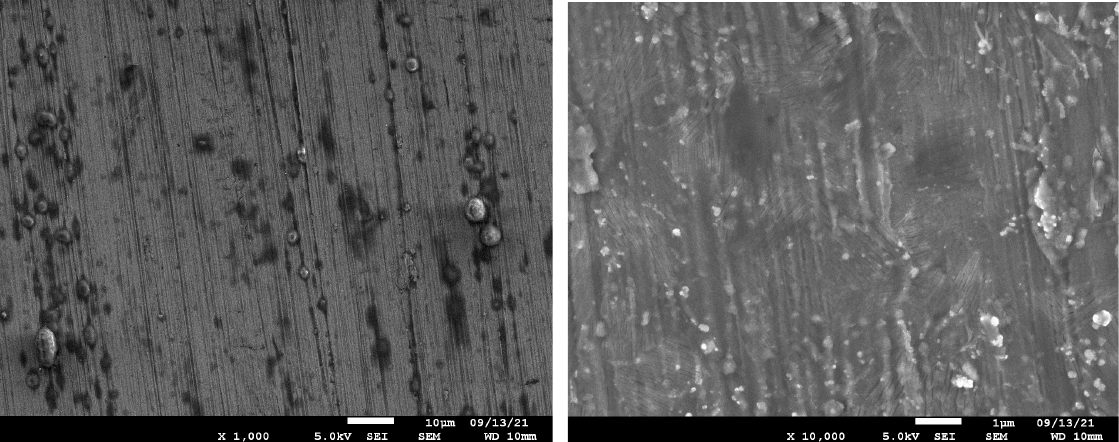
Figure 6. SEM images of the pure Cu ( left figure) and Cu structured with CNTs ( right figure).